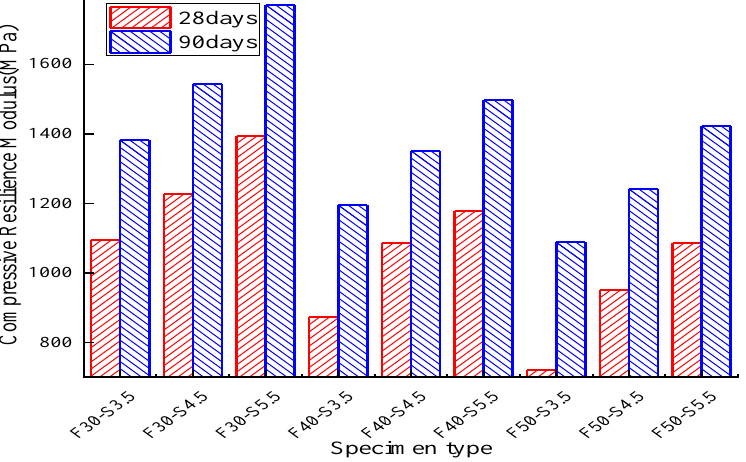
Figure 16. Analysis of the 90-day compressive-resilience modulus test: ( a ) cement dosage variation; ( b ) RAP replacement ratio.